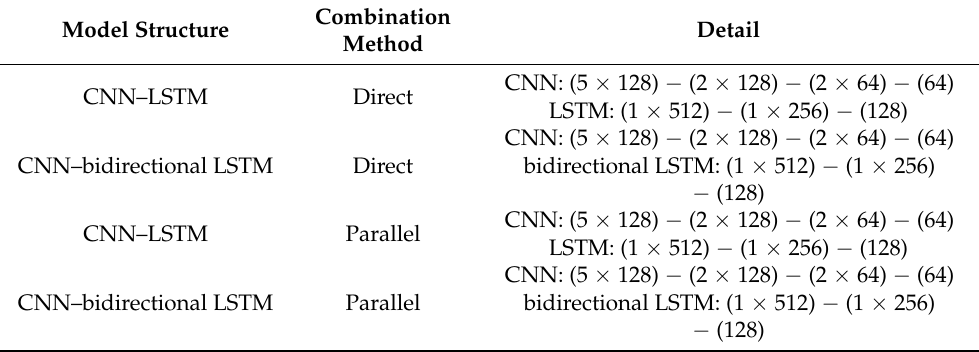
Table 3. Summary of model structures. Model